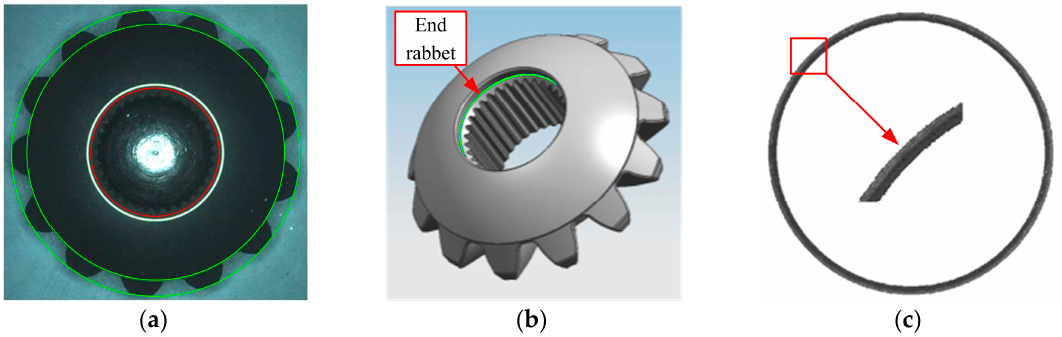
Figure 22. Size measurement of circumcircles and end rabbet: ( a ) Green circles are circumcircles and red is end rabbet circle. ( b ) Location of end rabbet; ( c ) Extracted rabbet and its amplified image.